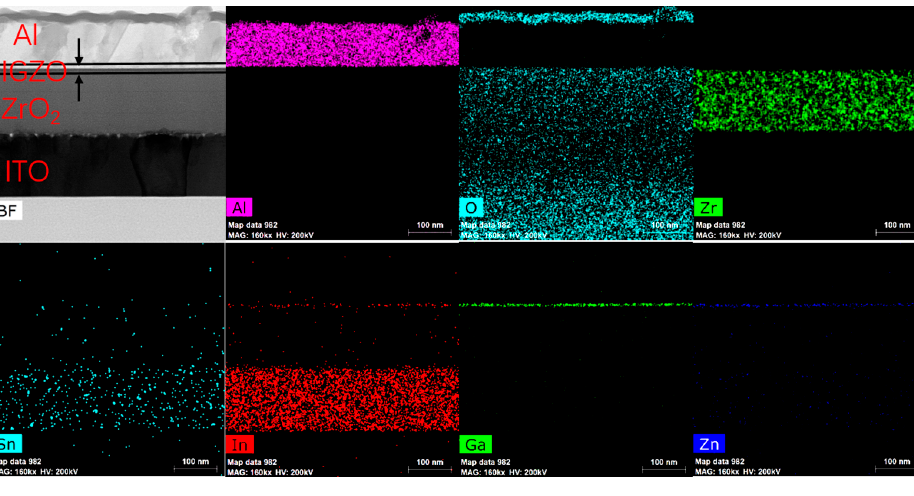
Figure 7. The cross-sectional high-resolution transmission microscopy (HRTEM) images of 0.6 M ZrO 2 -TFT.